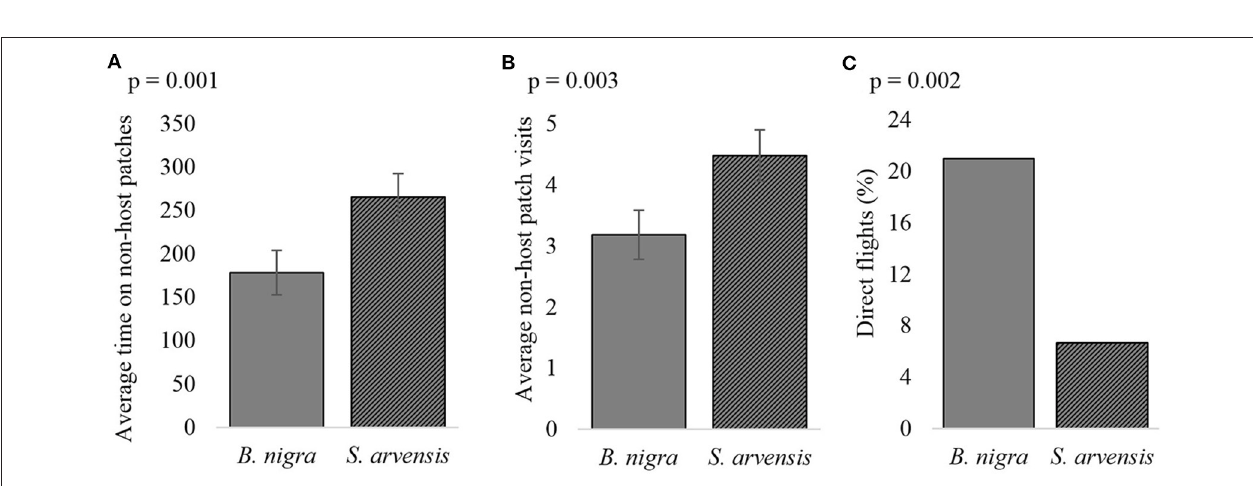
FIGURE 7 | The effect of different host plant species on (A) the average amount of time wasps spent on non-host patches, (B) the average number of visits to non-host patches and (C) the number of direct flights, when the host is found on either Brassica nigra or Sinapis arvensis . Error bars show the s.e. ( n =